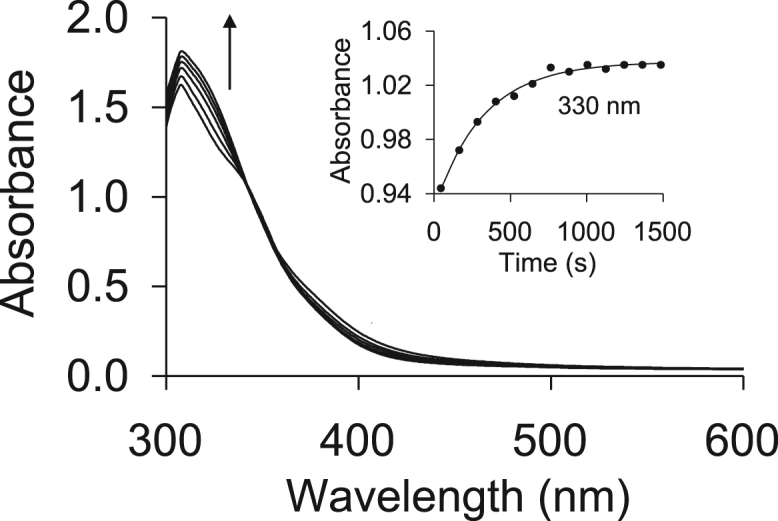
Time-based Uv/vis spectra for the first step in the oxidative addition of CH3I onto the Rh(I) metal centre, using the time trace of Rh(H3CCOCHCOCH3)CO(C6H5OPPh2) (4) as an example. The insert shows the absorbance vs time graph measured at 330 nm.